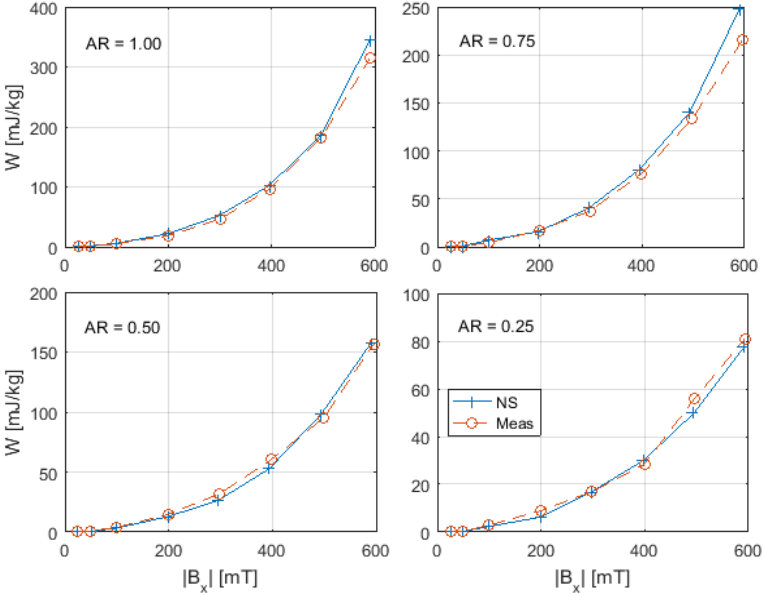
Figure 9. Comparison of the simulated and measured energy-loss curves for different value of the aspect ratio.